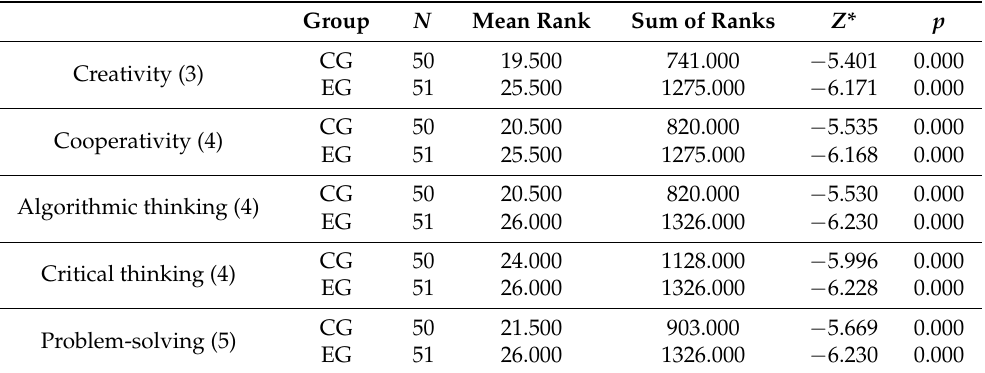
Table 5. The Wilcoxon signed-rank test on the CT skills’ five sub-dimensions of the two